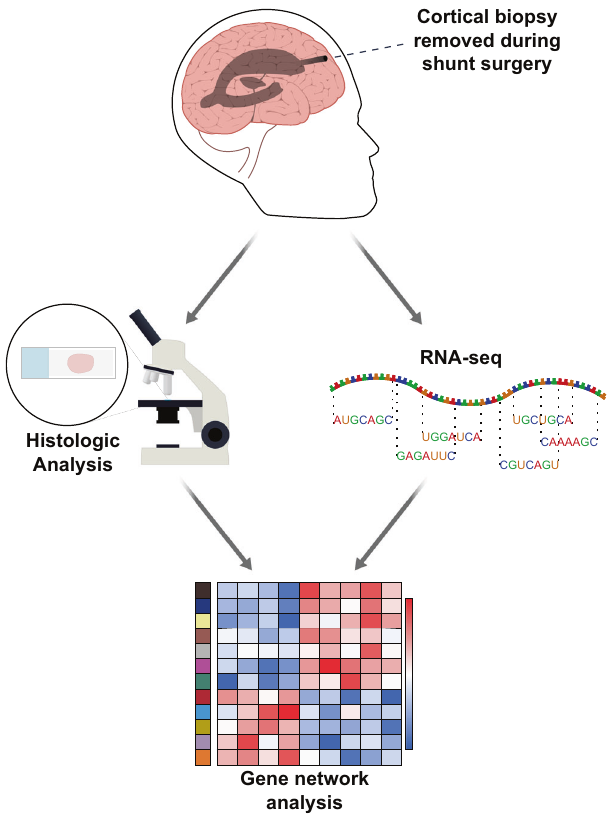
Fig. 1 Biopsies removed for ventricular shunting in the operating room are immediately split in half. Half of the biopsy is frozen in liquid nitrogen and sent for RNA-seq. The other half is formalin fi xed and paraf fi n embedded for subsequent pathologic analysis (see “ Methods ”